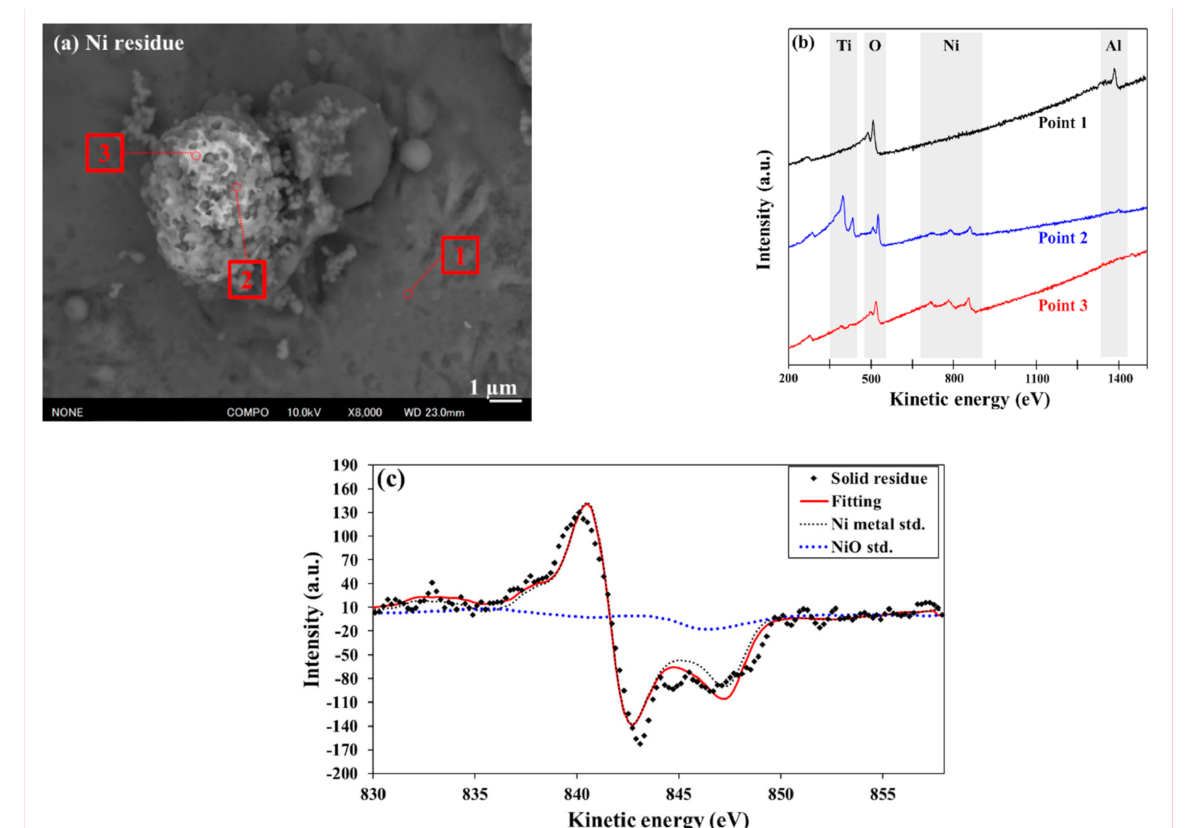
Figure 7. Auger electron spectroscopy (AES) results of the residue obtained after cementation of Ni 2+ from chloride solution using TiO 2 /Al: ( a ) photomicrograph, ( b ) wide scan energy spectrum of each points, and ( c ) the narrow scan energy spectrum of the Ni peak with fitting spectra of Ni and NiO.